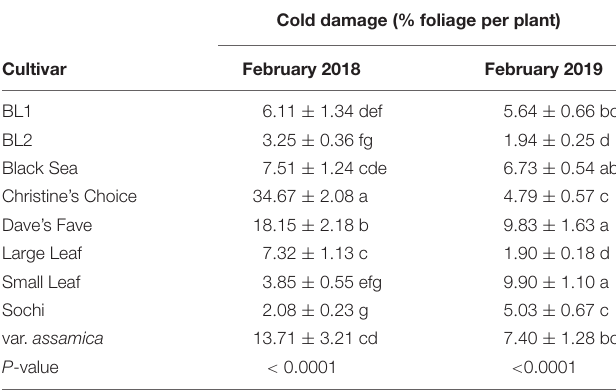
TABLE 2 | Cold damage of nine tea cultivars in February 2018 and February 2019 grown in Mississippi, United